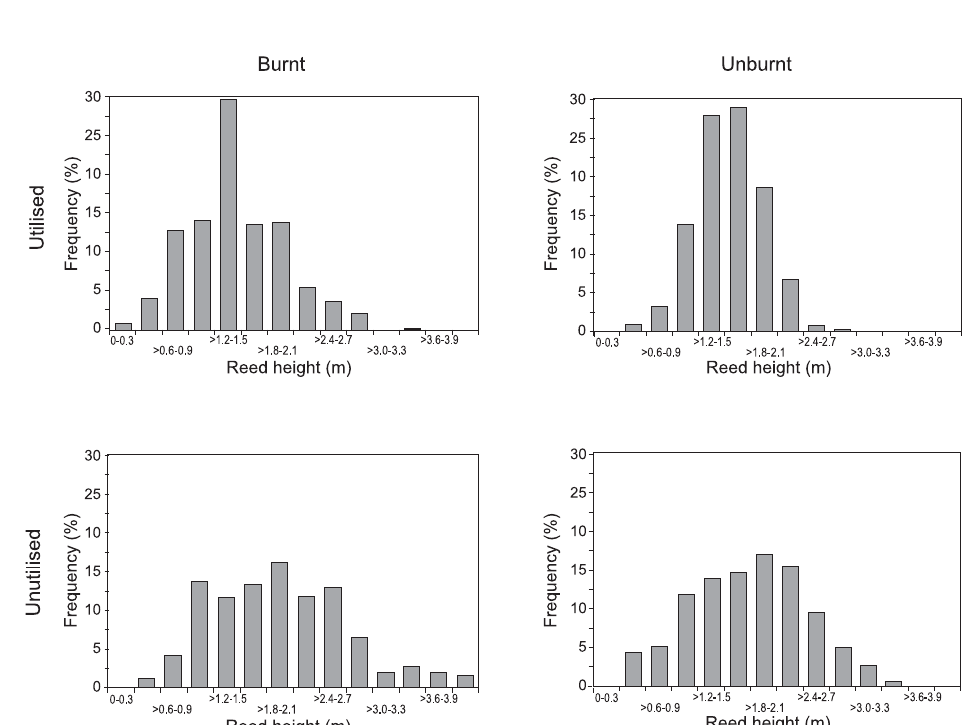
Fig. 6. Frequency distribution of different height classes under different utilisation regimes in the Muzi Swamp, Tembe Elephant Park as determined by harvesting trials in 2000. (a) burnt, utilised area; (b) burnt, unutilised area; (c) unburnt, utilised area; and (d) unburnt, unutilised